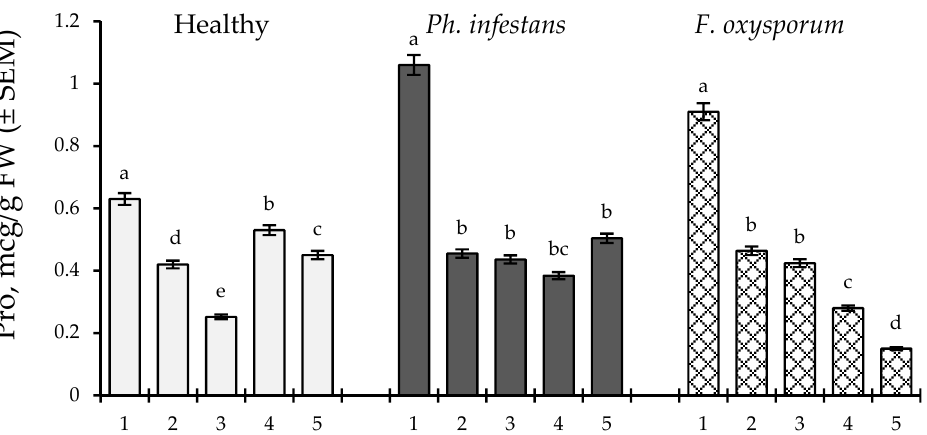
Figure 7. E ff ect of endophytic B. subtilis 10-4 and B. subtilis 26D, both individually and in compositions with SA, on Pro content in healthy and infected by Ph. infestans and F. oxysporum stored potato tubers (time of storage 5 months). 1 —control (non-inoculated with B. subtilis ), 2 — B. subtilis 10-4; 3 — B. subtilis 10-4 + SA; 4 — B. subtilis 26D; 5 — B. subtilis 26D + SA. The bars are the means of three repetitions ± SEM. Di ff erent letters indicate a significant di ff erence between the means at the probability level of p < 0.05.